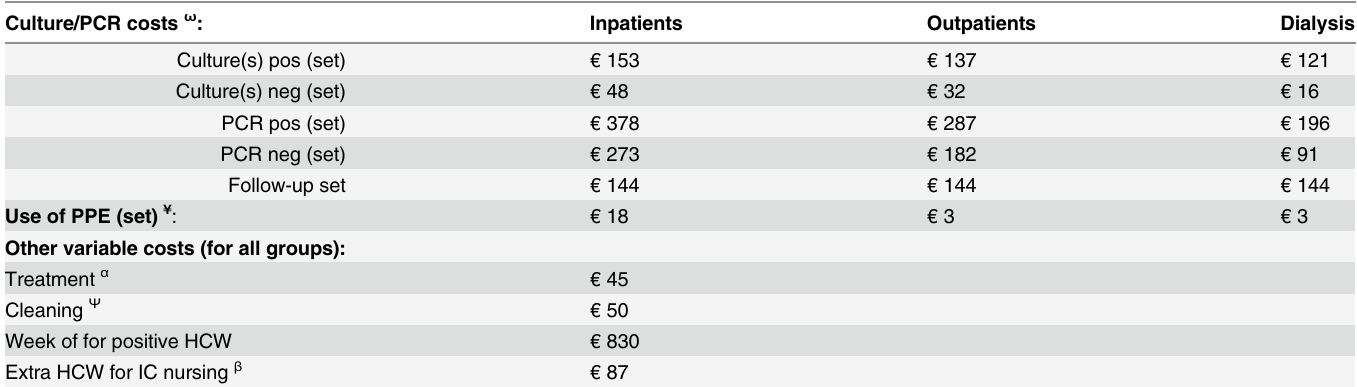
Table 1. Variable